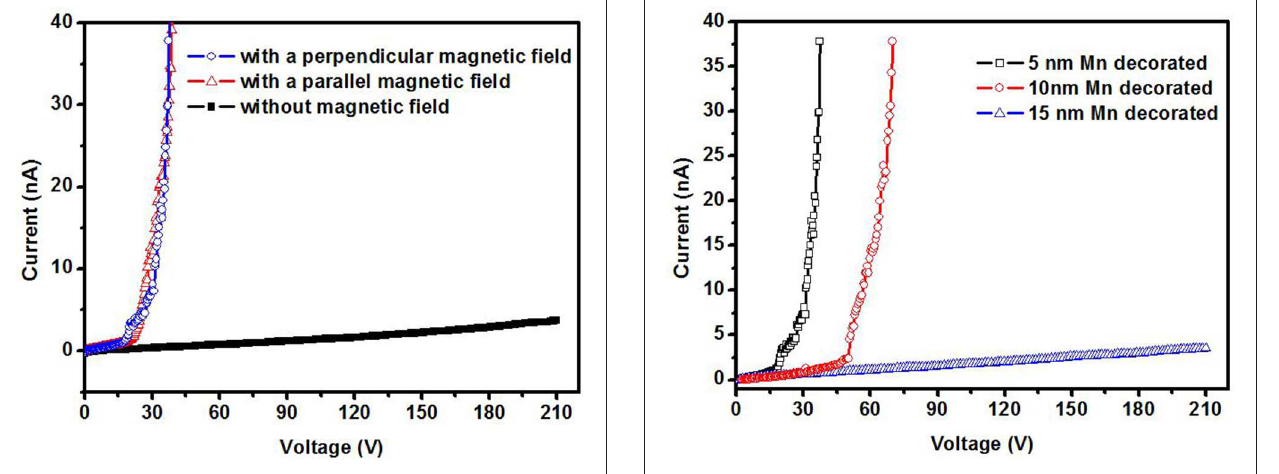
FIGURE 6 | Air ionization curve for a 5nm Mn decorated ZnO nanorods electrode under parallel and perpendicular magnetic field.